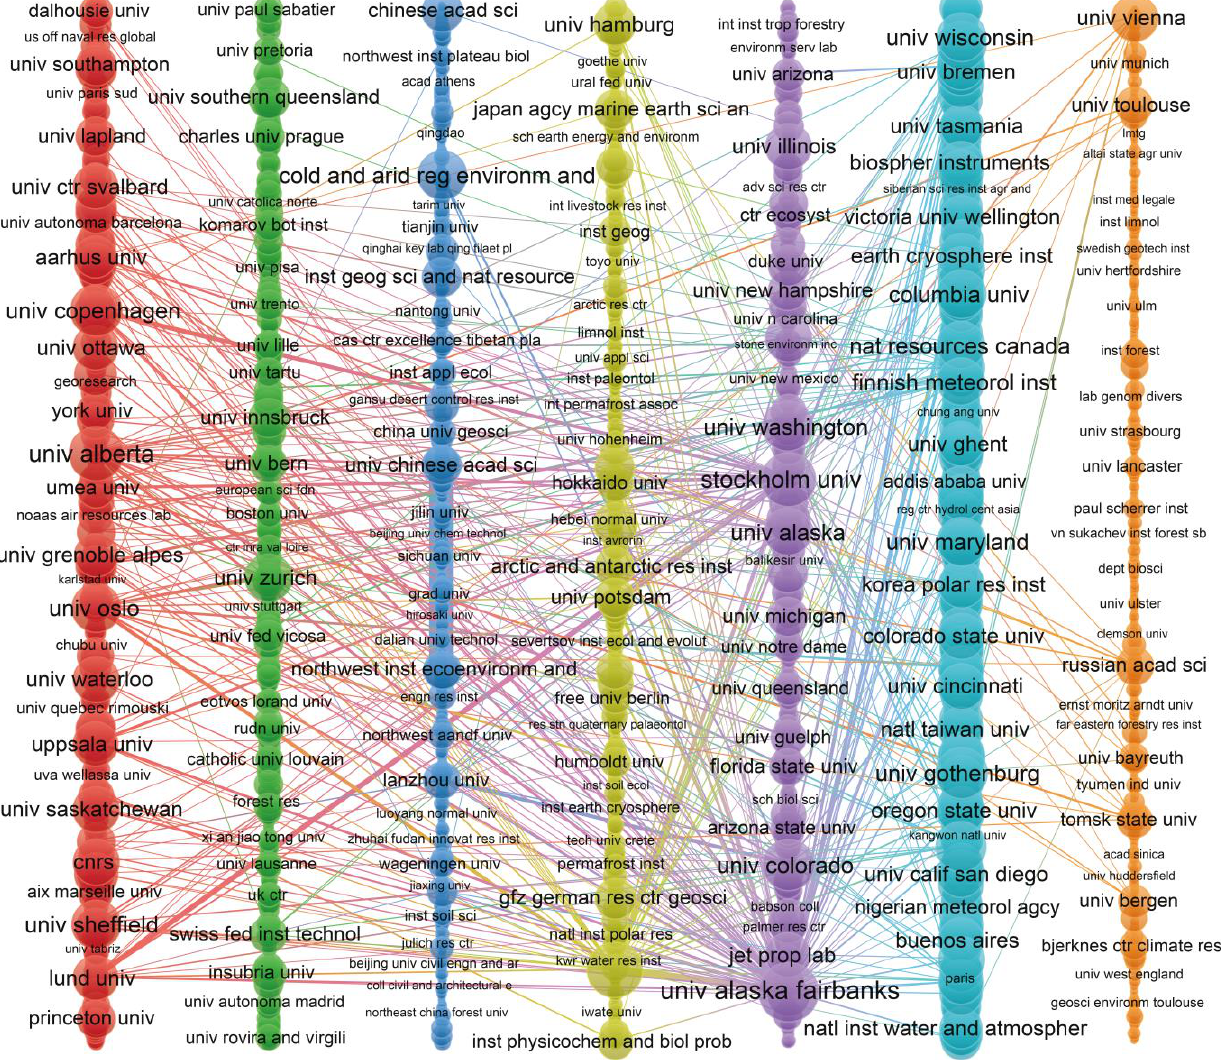
Figure 8. Map showing research collaboration between institutions. Different colors represent different clusters; the size of a circle represents the frequency of cooperation with other institutions, and the connection line indicates the amount of cooperation between institutions exceeding